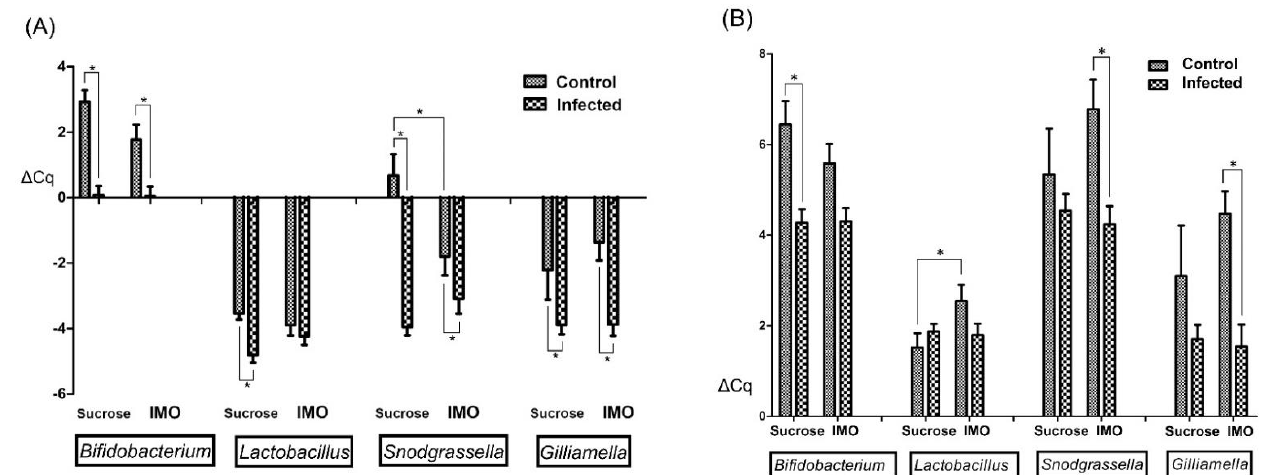
Figure 5. Relative qPCR results of the hindgut and fecal samples indicating the population ratio alterations. The results were normalized by the qPCR results of universal bacteria primers. The lower ∆ Cq indicates the higher ratio within the gut microbiota. ( A ) Hindgut results, ( B ) Fecal sample qPCR results. Significances are labeled by asterisks.